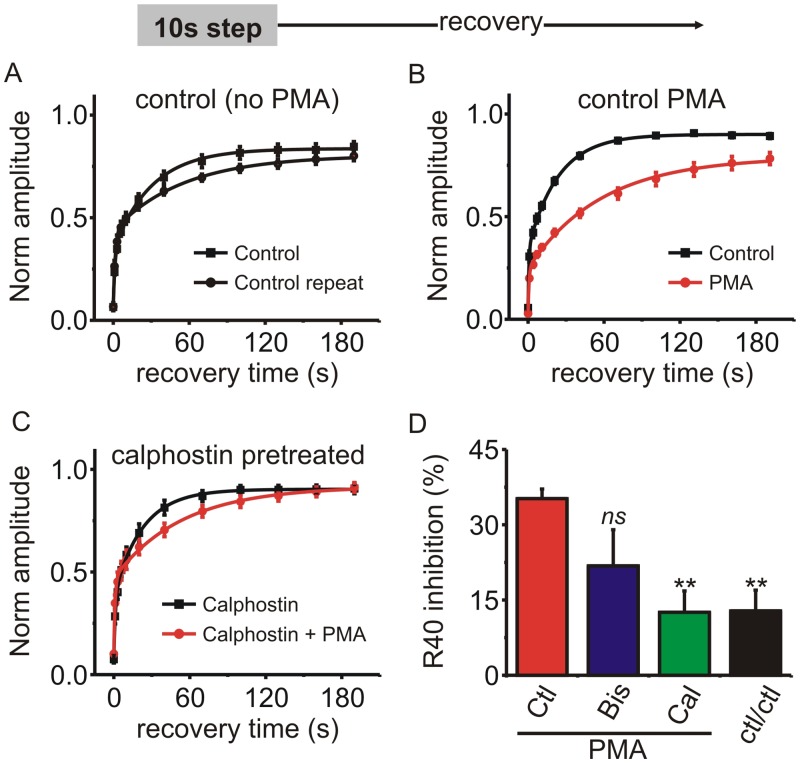
PMA prolonged recovery of I
Ca from inactivation in adrenal chromaffin cells.
(A–C) Chromaffin cells were stimulated with a 10s step depolarization and recovery from inactivation tracked at the indicated time points. I
Ca amplitude (normalized to that before the 10 step depolarization) is plotted for each of the recovery time points and the mean data fit with a double exponential (solid lines). A) Control cells with no PMA treatment (n = 11) (fit parameters: control Y0 = 0.07, A1 = 0.29, A2 = 0.49, t1 = 1.5 s, t2 = 32.1 s; control repeat Y0 = 0.07, A1 = 0.36, A2 = 0.37, t1 = 1.5 s, t2 = 52.6 s: fit comparison F = 1.66 p = 0.21). B) Control cells with PMA (n = 6) (fit parameters: control Y0 = 0.05, A1 = 0.28, A2 = 0.56, t1 = 0.7 s, t2 = 23.5 s; PMA Y0 = 0.03, A1 = 0.24, A2 = 0.55, t1 = 1.1 s, t2 = 69.6 s, comparison of fits F = 35.2 p < 0.0001). C)Cells pretreated with calphostin C (n = 6) (fit parameters: calphostin Y0 = 0.08, A1 = 0.31, A2 = 0.52, t1 = 1.2 s, t2 = 22.6 s; calphostin + PMA Y0 = 0.10, A1 = 0.36, A2 = 0.45, t1 = 1.0 s, t2 = 52.7 s, comparison of fits F = 1.73 p = 0.19). (D) The percent inhibition of recovery at the 40 s time point was calculated (R40—see results section for more detail). The bar graph shows R40 produced by PMA in control cells (PMA; n = 6), cells pretreated with bisindolylmaleimide-1 (Bis; n = 4), and cells pretreated with calphostin C (Cal; n = 6). The R40 for control cells stimulated twice in the absence of PMA is also shown (ctl/ctl; n = 11). Statistical significance compared to the control PMA cells (red bar) was determined using one-way ANOVA and Dunnett’s post-test (ns, not significantly different, ** p < 0.01).